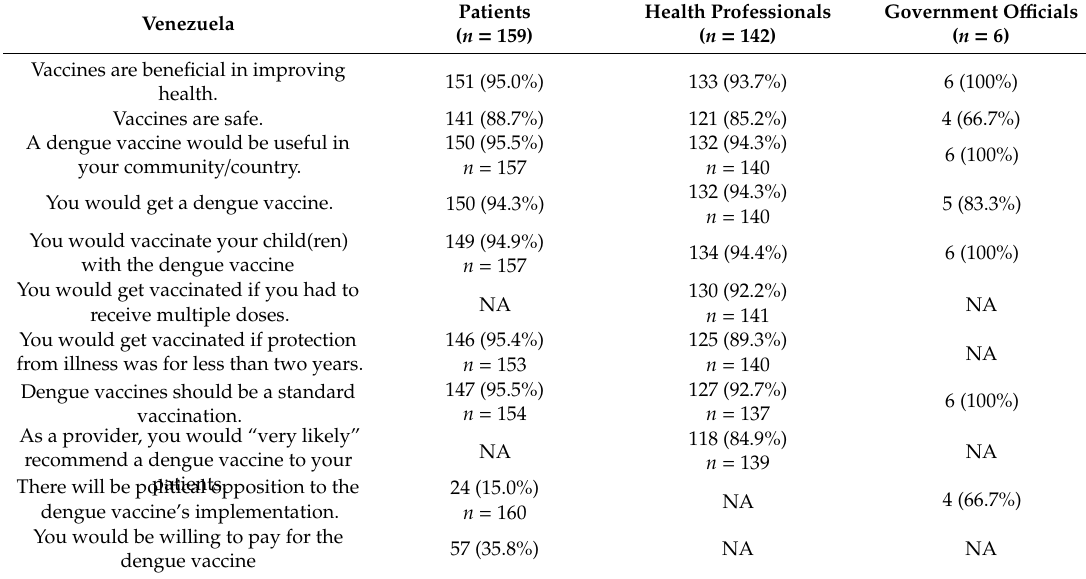
Table 4. Attitudes towards vaccines. Percentage of respondents who “agree” with the